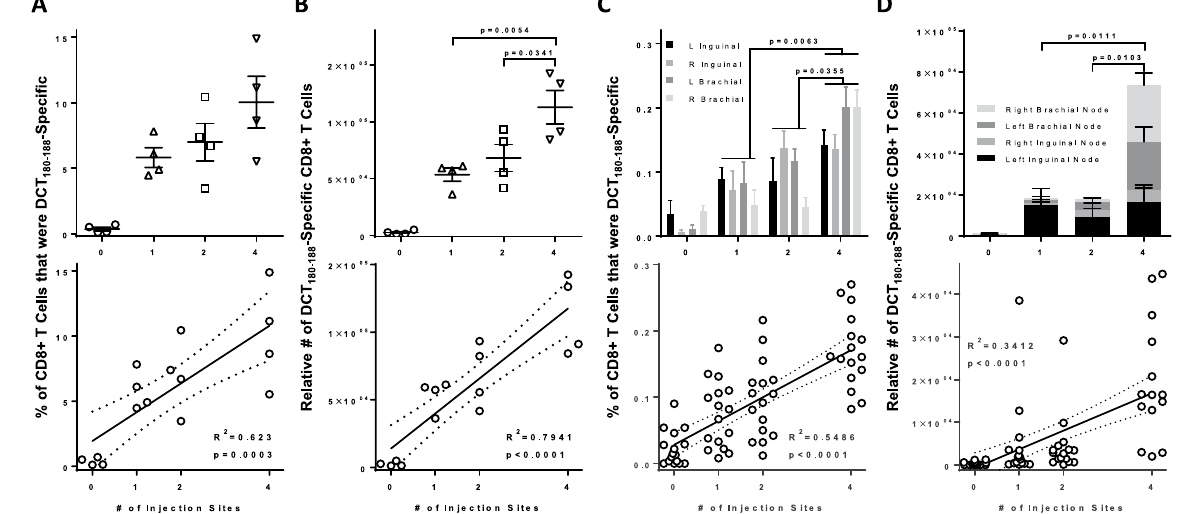
Figure 3. Multi-site vaccination increased the magnitude of transgene-specific CD8 + T cells in spleens and lymph nodes. Tumor-free female C57BL/6 mice were vaccinated intramuscularly with 1 × 10 8 pfu of recombinant human serotype 5 adenovirus expressing the melanoma-associated antigen dopachrome tautomerase, with injections spread across one (semitendinosus; left hind limb), two (semitendinosus of both hind limbs) or four (semitendinosus of both hind limbs and the triceps brachii of both forelimbs) sites. ( A , B ) Spleen and ( C , D ) lymph node-derived CD8 + T cells specific for the immunodominant self-epitope DCT 180–188 were quantified fourteen days post-vaccination by flow cytometric assessment of intracellular cytokine staining after ex vivo re-stimulation with peptides. ( A , B ) One-way analysis of variance with Tukey’s multiple comparison test (upper panels) and Pearson correlation analysis (lower panels) was performed for the ( A ) frequency and ( B ) total number of antigen-specific splenic CD8 + T cells ( n = 4/treatment). ( C–D ) Two-way analysis of variance with Tukey’s multiple comparison test (upper panels) and Pearson correlation analysis (lower panels) was performed for the ( C ) frequency and ( D ) total number of antigen-specific lymph node-derived CD8 + T cells ( n = 4/treatment; L = left node, R = right